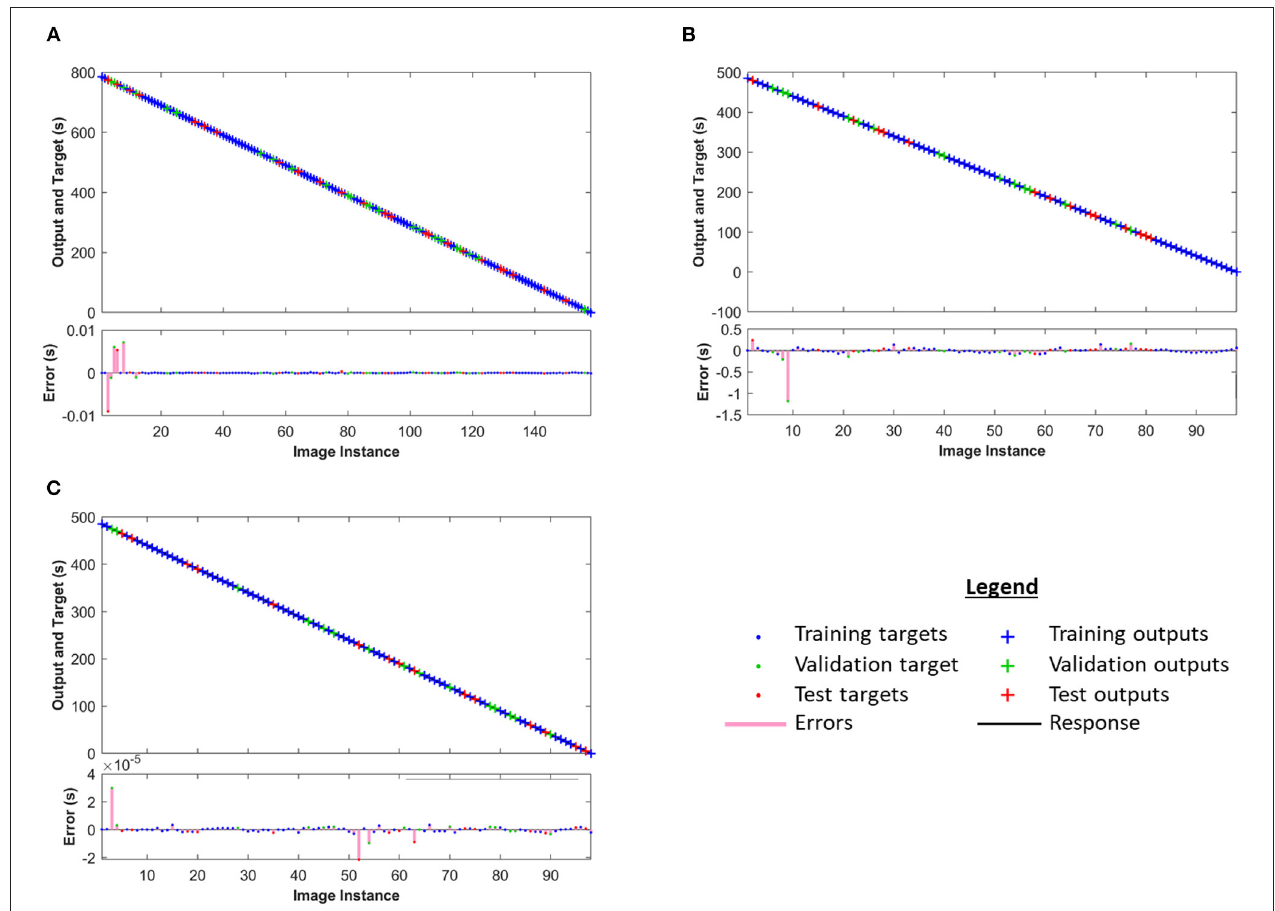
FIGURE 6 | Predictions of cleaning time remaining from Nonlinear Autoregressive Network with Exogenous (NARX) neural network training on (A) dataset 1, (B) dataset 2, and (C) dataset 1 + 2.